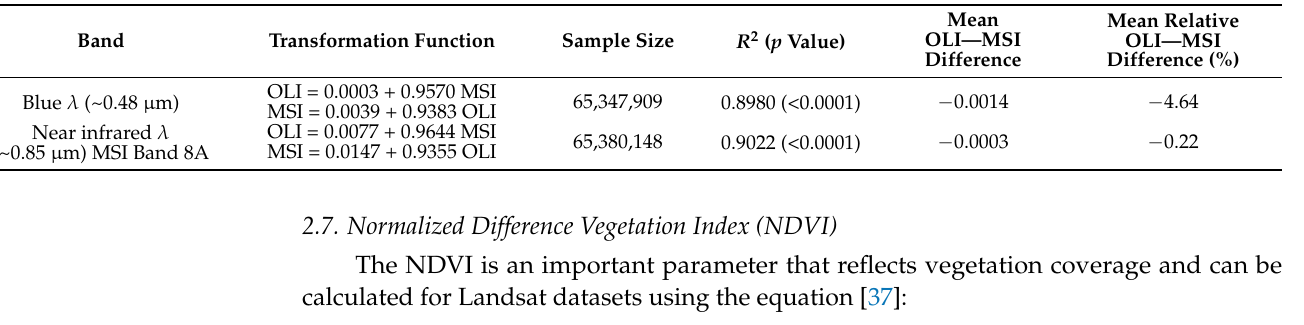
Figure 3. Location of the areas in the Landsat and Sentinel images (the image with a red border is the Sentinel image, and the image with a blue border is the Landsat image).